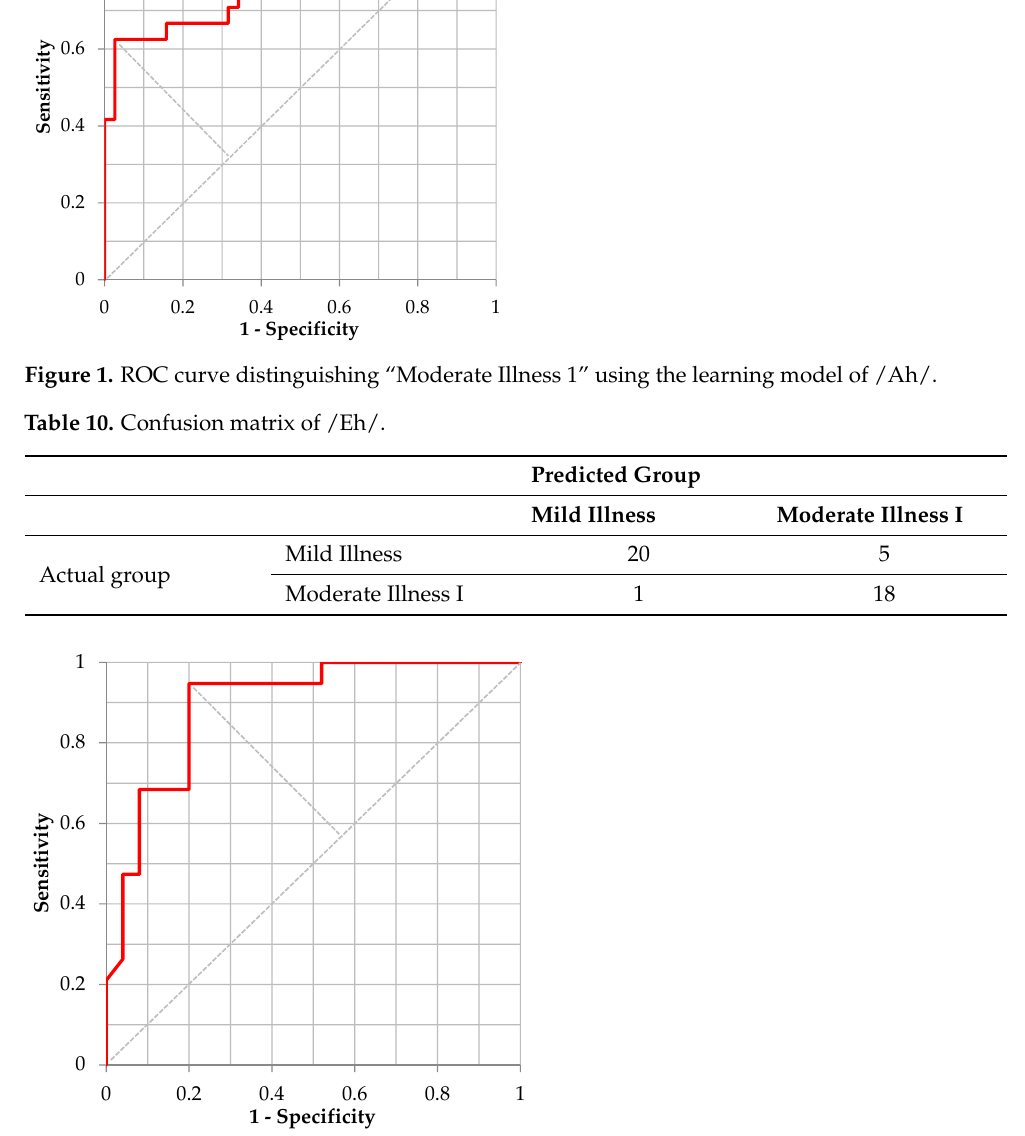
Figure 2. ROC curve distinguishing “Moderate Illness 1” using the learning model of /Eh/.